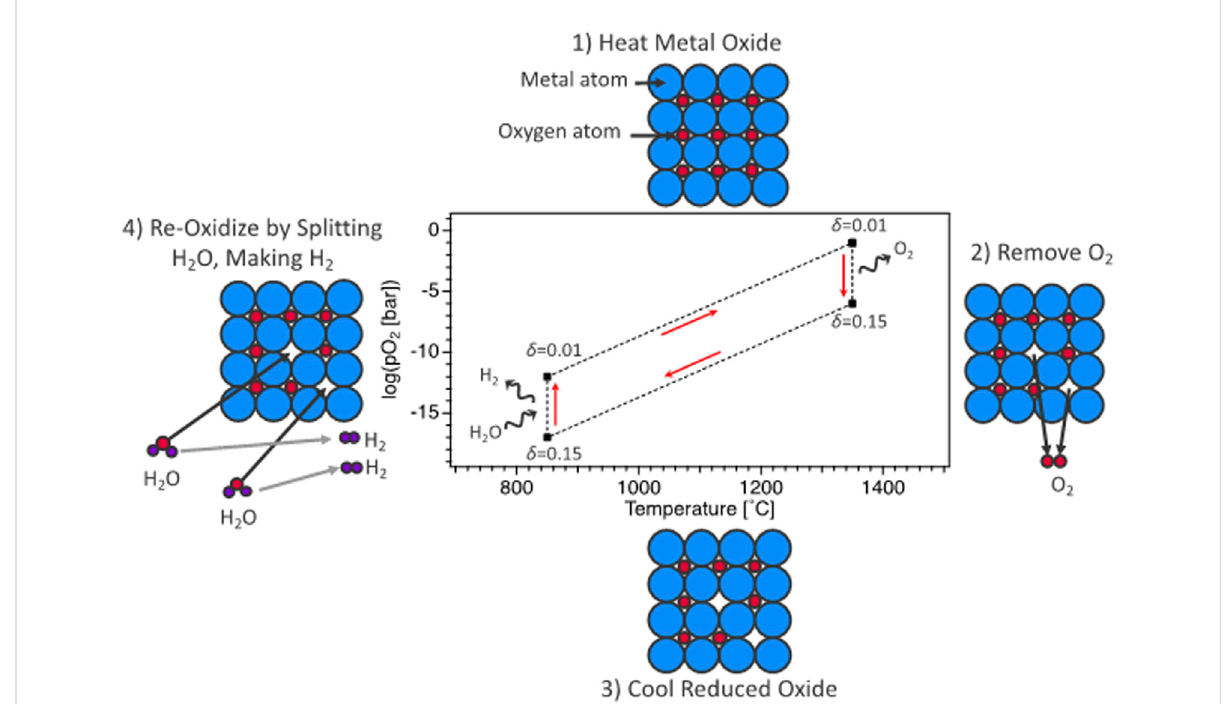
FIGURE 1 Representation of oxygen-vacancy STCH cycle divided into four thermochemical steps: 1) heating of metal oxide at constant (low) vacancy concentration, 2) high-temperature reduction resulting in oxygen vacancy creation, 3) cooling of metal oxide at constant (high) vacancy concentration, and 4) steam reaction where STCH material vacancy concentration decreases (reoxidization) and H 2 O is reduced to H 2